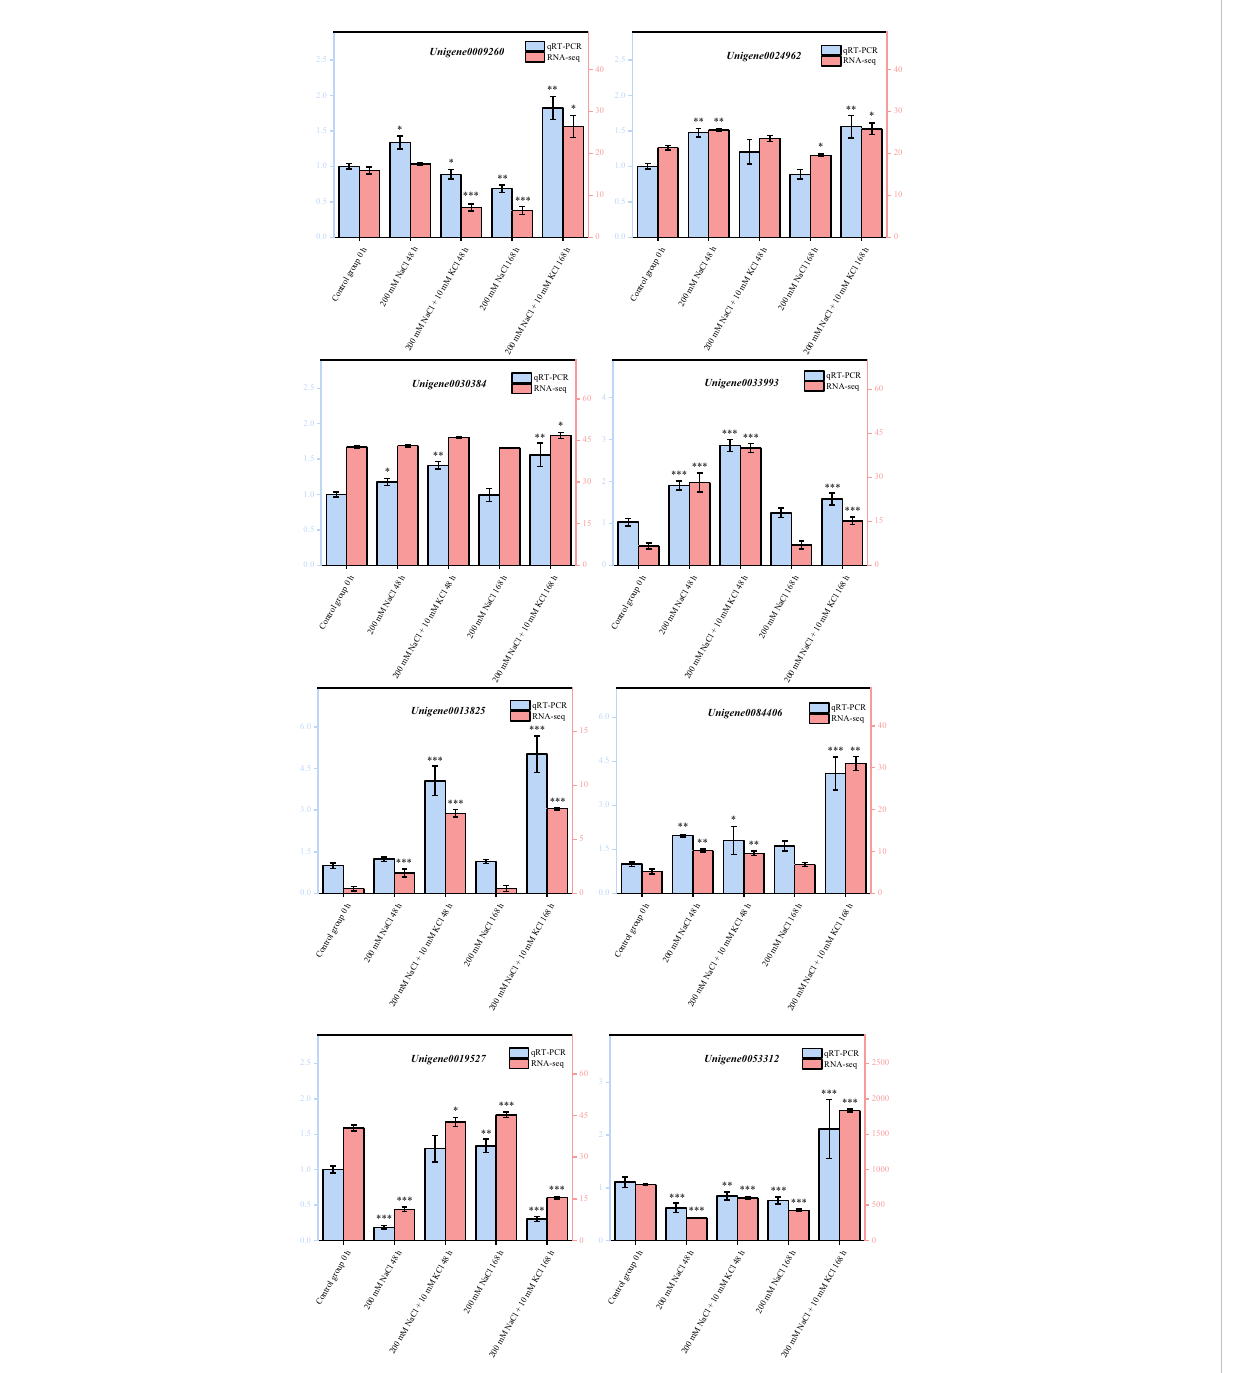
FIGURE 7 Validation of DEGs by qRT-PCR. (8 DEGs were randomly selected for quantitative real-time PCR (qRT-PCR) validation, the error bars were obtained from multiple replicates of qRT-PCR. Note: p ≥ 0.05 is not marked; 0.01 < p < 0.05 is marked as *0.001 < p < 0.01 is marked as ** p ≤ 0.001 is marked as *** ▬ qRT-PCR: Numerical value has been shown on the left side of the Y axis; ▬ RNA-seq: Numerical value has been shown on the right side of the Y axis; all of the data inside the fi gure are relative quantitative values, no unit